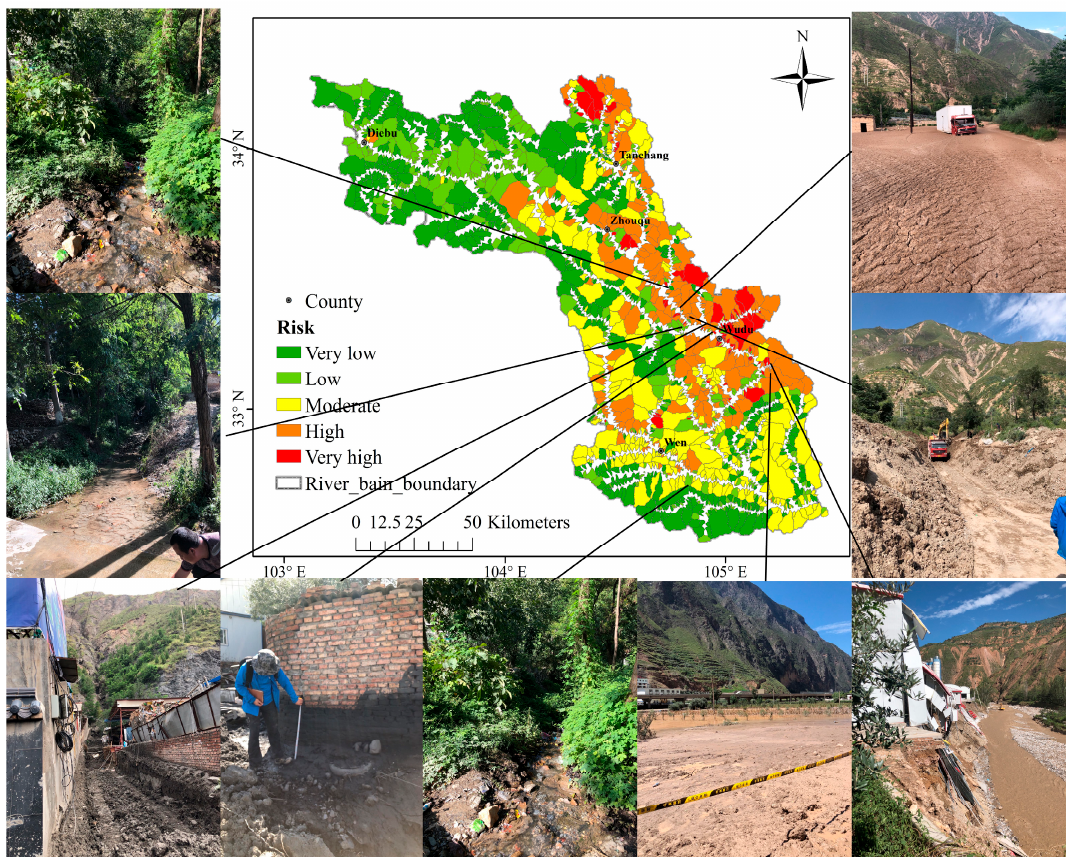
Figure 15. Spatial distribution of debris flow hazard and landscape photos in the BRB.